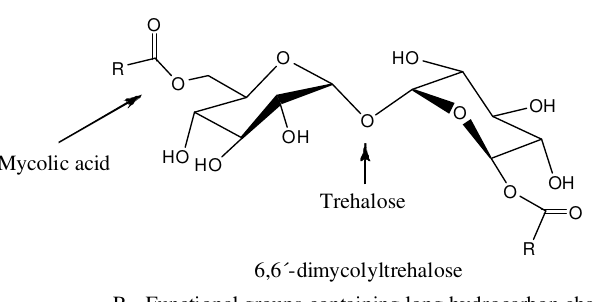
FIGURE 2. Structure of 6,6´-dimycolyltrehalose 34.